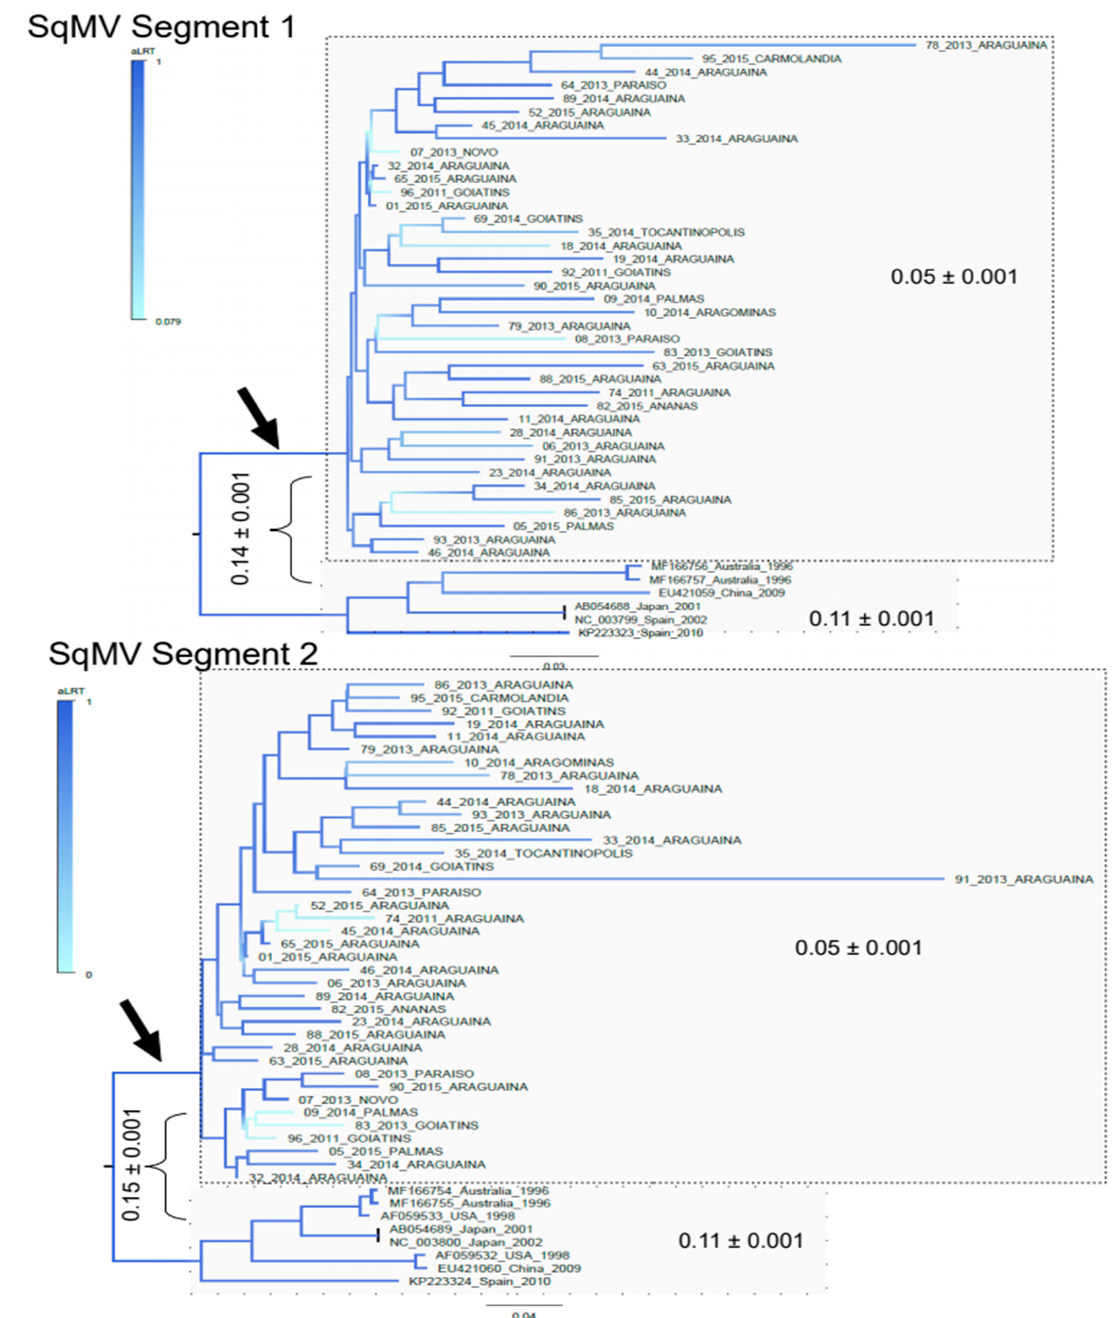
Figure 1. Maximum likelihood tree of genome segments of Squash mosaic viruses. Trees were inferred in FastTree using GTR + gamma correction and the proportion of invariable sites model as selected by the jModelTest software. Branch support was achieved by approximate likelihood ratio test (aLRT) and is shown in a color scale. Scale is indicated in the base of each tree and indicate nucleotide substitutions per site. These trees ware rooted at the midpoint. Numbers indicate the genetic distances and their standard.